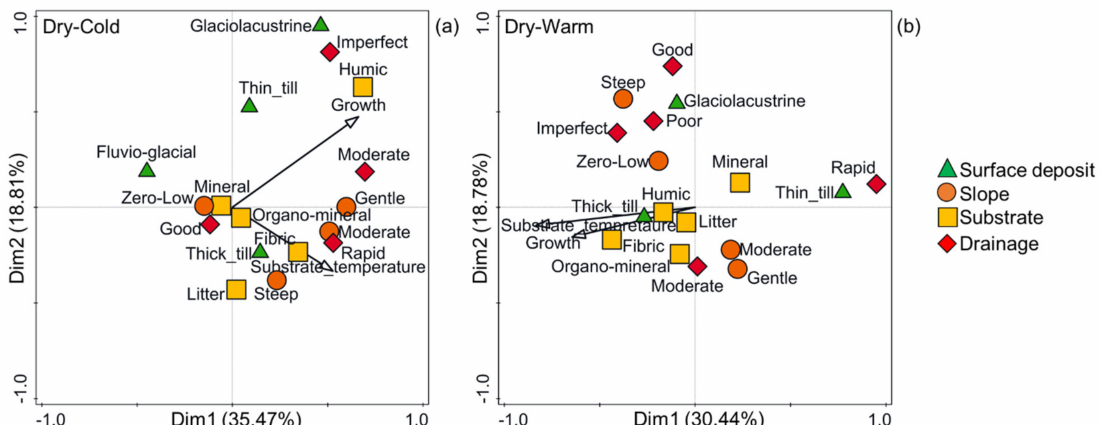
Figure 3. Principal component analysis (PCA) summary of jack pine growth responses to local variables at the microsite level and soil variables at the stand level, within four regions that are delineated by annual precipitation and average temperature: ( a ) Dry–Cold; and ( b )